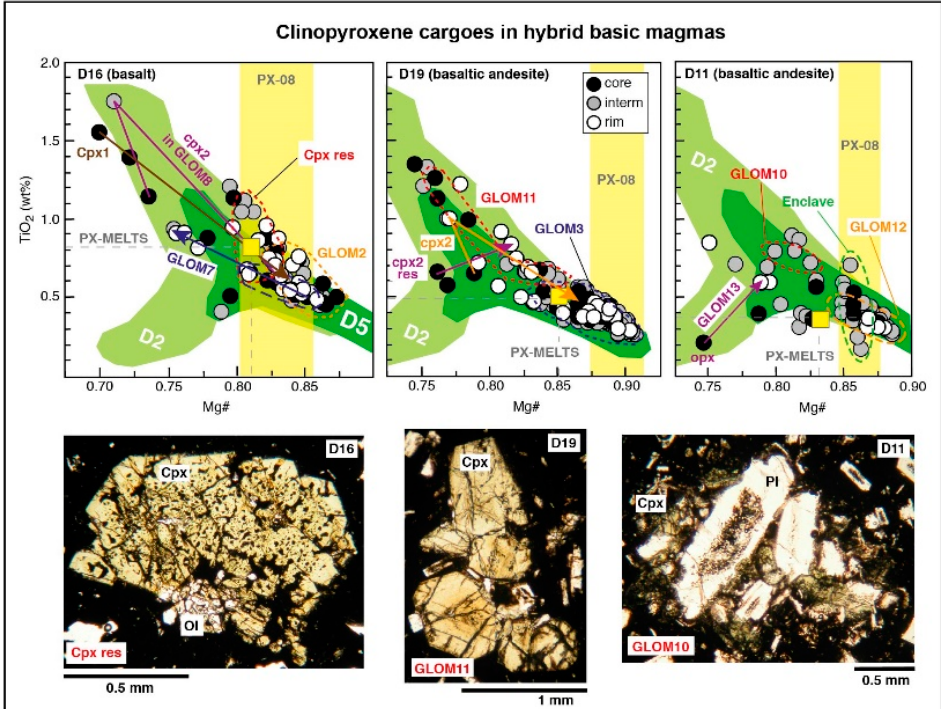
1c. Boxes “Stage B” and “Stage C” mark the location of the crystallization events recorded by the